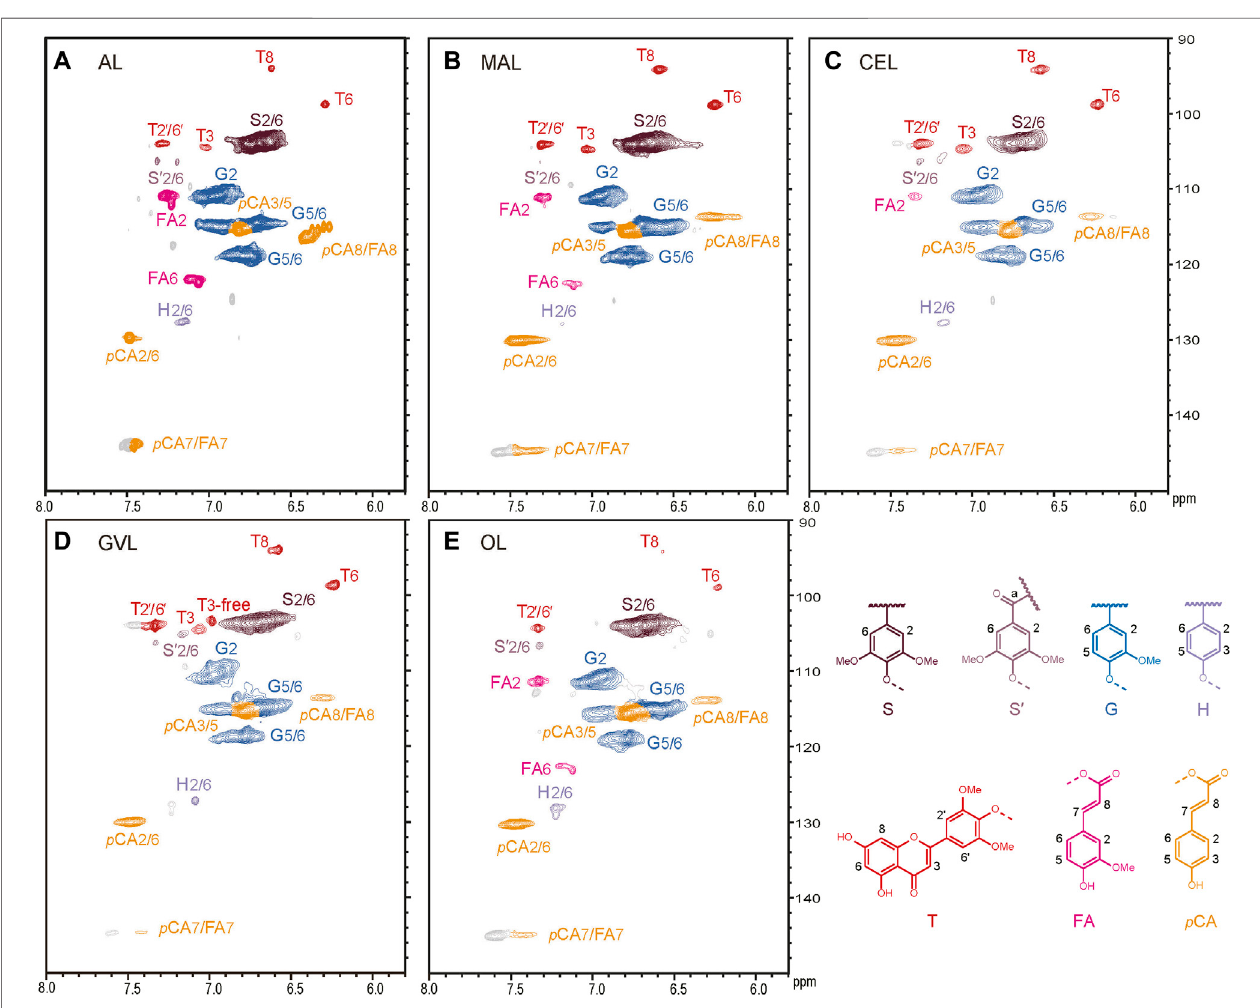
FIGURE2| Aromaticregionofthe2DHSQCspectraof (A) alkalilignin(AL), (B) mildacidolysislignin(MAL), (C) cellulaseenzymaticlignin(CEL), (D) γ -valerolactone lignin (GVL), and (E) organosolv lignin (OL).